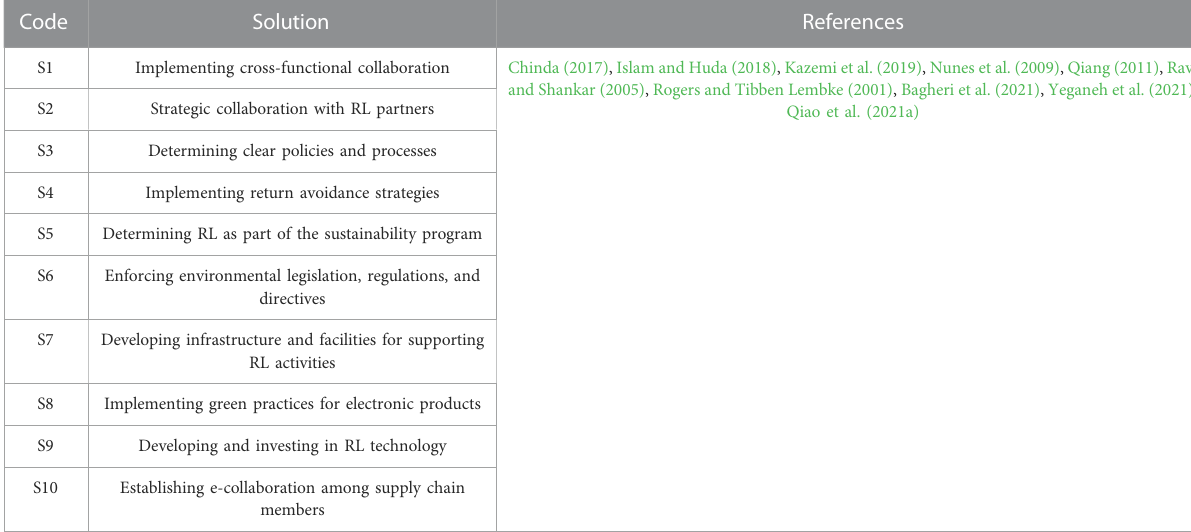
FIGURE 2 Proposed research framework.